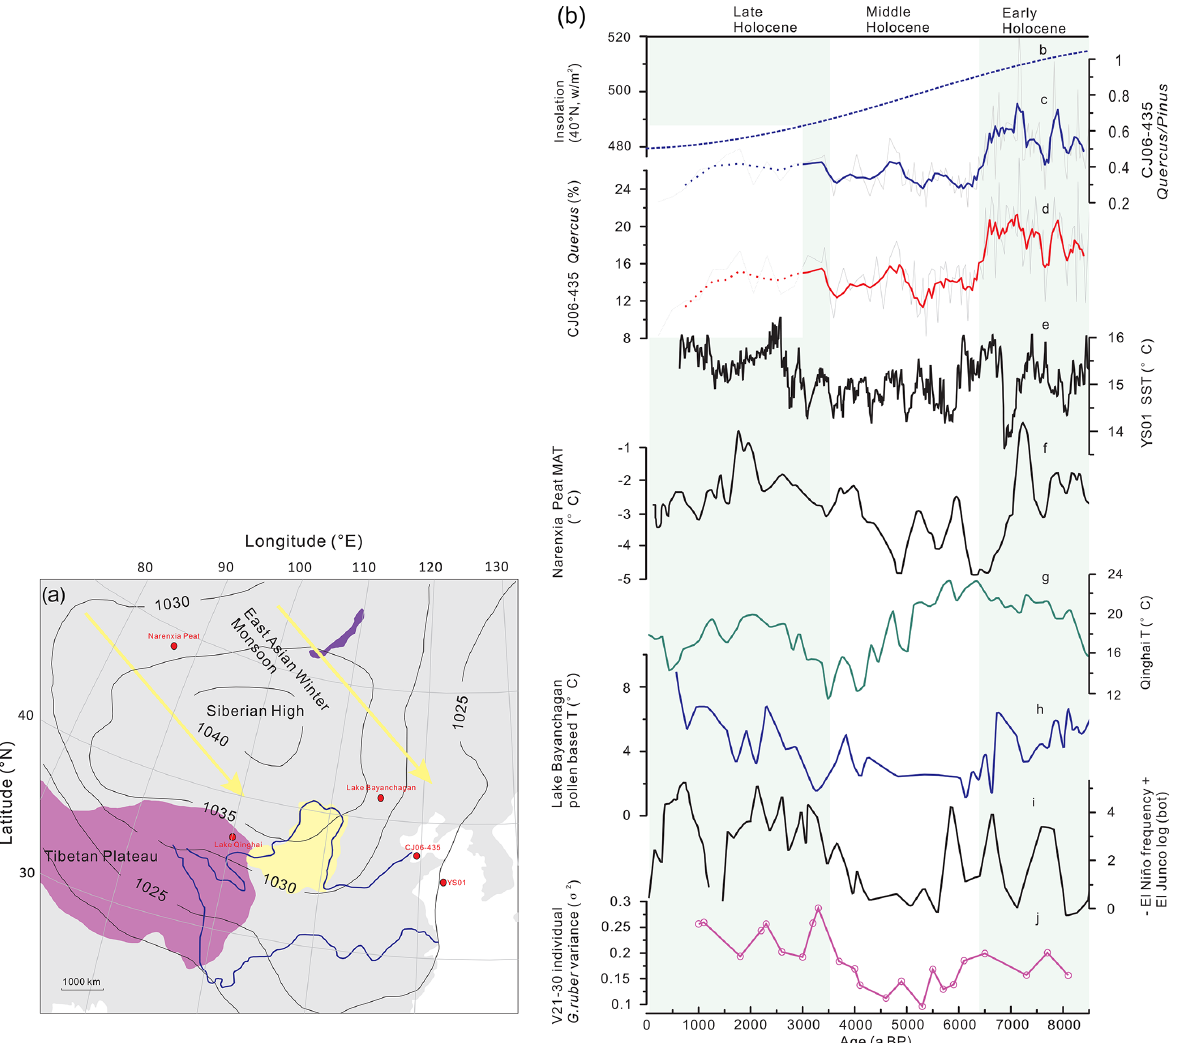
Figure 9. Comparison of relevant Holocene temperature records with solar irradiance and El Niño–Southern Oscillation (ENSO) proxy records derived from the equatorial Pacific. (a) Locations of the sites where the Holocene temperature records are derived. The schematic large-scale diagram is modified from Hao et al. (2017). In the diagram, the purple area is the Tibetan Plateau, the yellow area is the Chinese Loess Plateau, and red circle refers to the corresponding study sites. (b) Summer (mean of June) insolation irradiance for the Northern Hemisphere (40 ◦ N). (c, d) Quercus / Pinus ( Q/P ) rate and Quercus pollen percentage records from core CJ06-435; the bold blue and bold red lines are the five-point running averages for Quercus / Pinus and Quercus , respectively. As introduced in Sect. 5.4, there might be some deposition hiatus between 3000 BP and 1855CE. Thus, Q/P rate and Quercus pollen percentage records between 3000 BP and 1855CE (cid:48) are for reference only. (e) U K sea surface temperature (SST) record from YS01 core in the south Yellow Sea (Jia et al., 2019). (f) Pollen- 37 based mean annual temperature (MAT) record from Narenxia peat in the southern Altai Mountains (Feng et al., 2017). (g) U K inferred 37 temperature record at Lake Qinghai (Hou et al., 2016). (h) Pollen-based mean annual temperature record from Lake Bayanchagan in Inner Mongolia, northern China (Jiang et al., 2006). (i) Botryococcene concentrations in the El Junco sediment, a proxy for frequency of El Niño events (Zhang et al., 2014). (j) Variance of δ 18 O values of individual planktonic foraminifera ( G. ruber ) in sediment core V21–30 from the Galápagos region, a proxy for ENSO variance (Koutavas and Joanides,